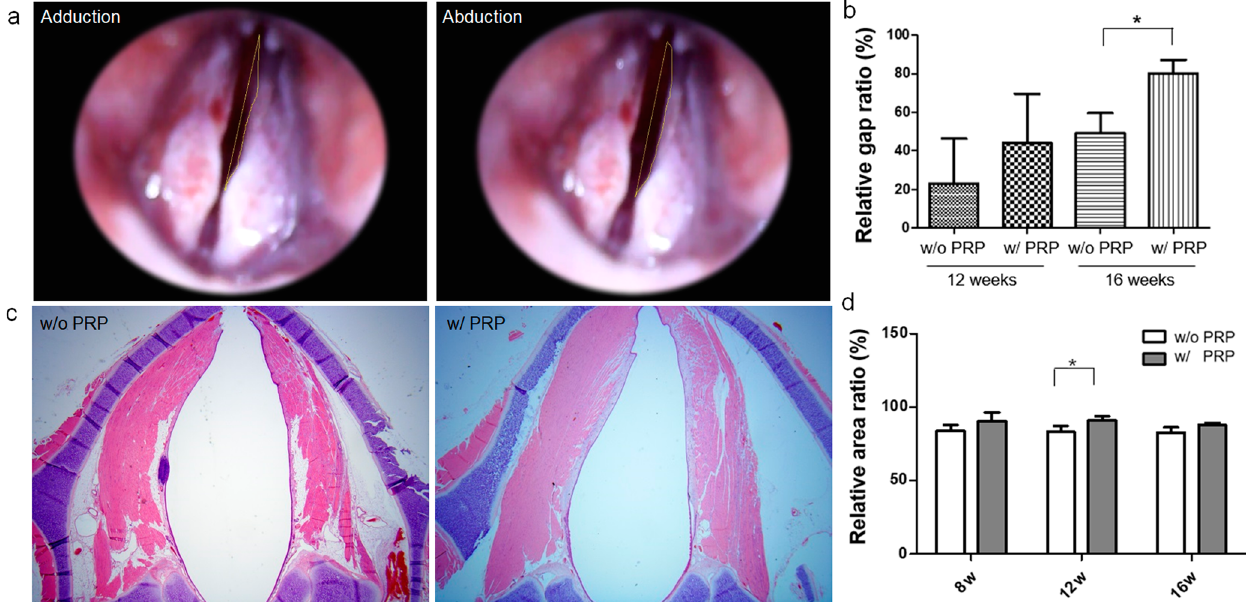
Fig. 6 Endoscopic examinations of vocal cord movement and histologic analysis of vocalis muscle. a Captured images of the adducted position after nerve stimulation and of the abducted position. A video clip (Video S2) of both vocal cord movement after electrical stimulation is available in the Supplementary Materials. b Relative gap ratios between vocal cords in adduction and abduction were signi fi cantly greater in the PRP-loaded NGC group (80.23 ± 6.91%) than in the non-loaded group (48.99 ± 10.71%) ( P = 0.018). c Axial section of vocalis muscle: in the PRP group, muscle thicknesses were similar on left and right sides, but in the non-loaded group, left-side muscles were atrophied. d The PRP group had signi fi cant higher vocalis muscle area ratios than the non-loaded group at 12 weeks post-implantation ( P = 0.033). NGC nerve guidance conduit, PRP platelet-rich